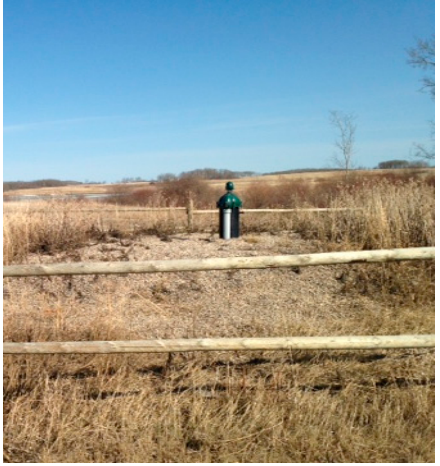
Figure 5. Unprotected community well-head (vegetation encroachment, no mounding).